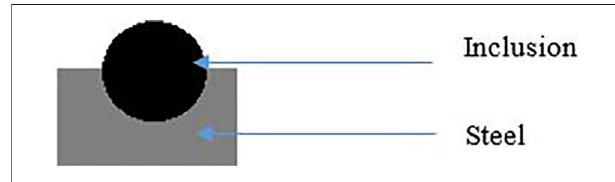
FIGURE 7 | Schematic of dimple